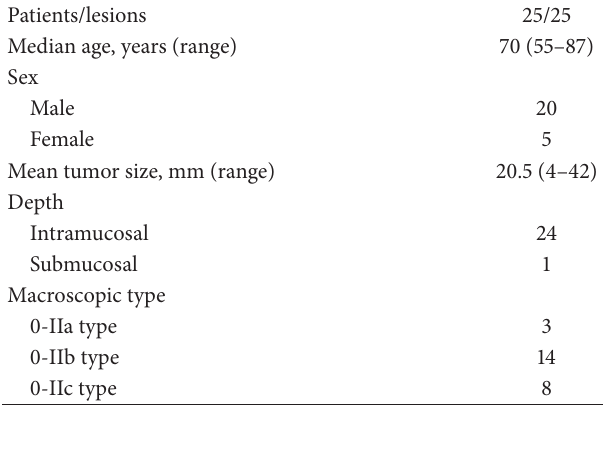
Table 2: Inter- and intraobserver agreement ( 𝜅 -value) for ranking